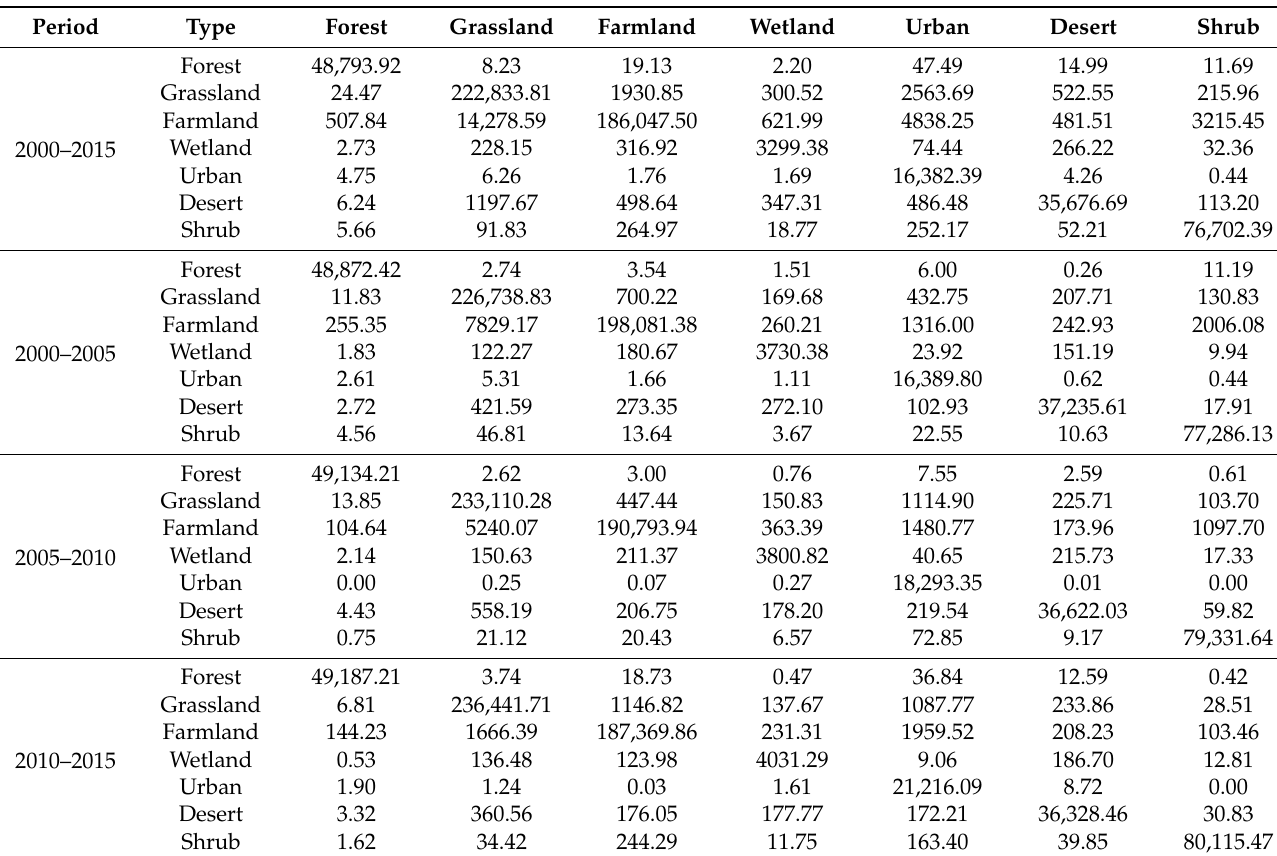
Table 5. Transfer matrix of different ecosystems from 2000 to 2015 (unit: km 2